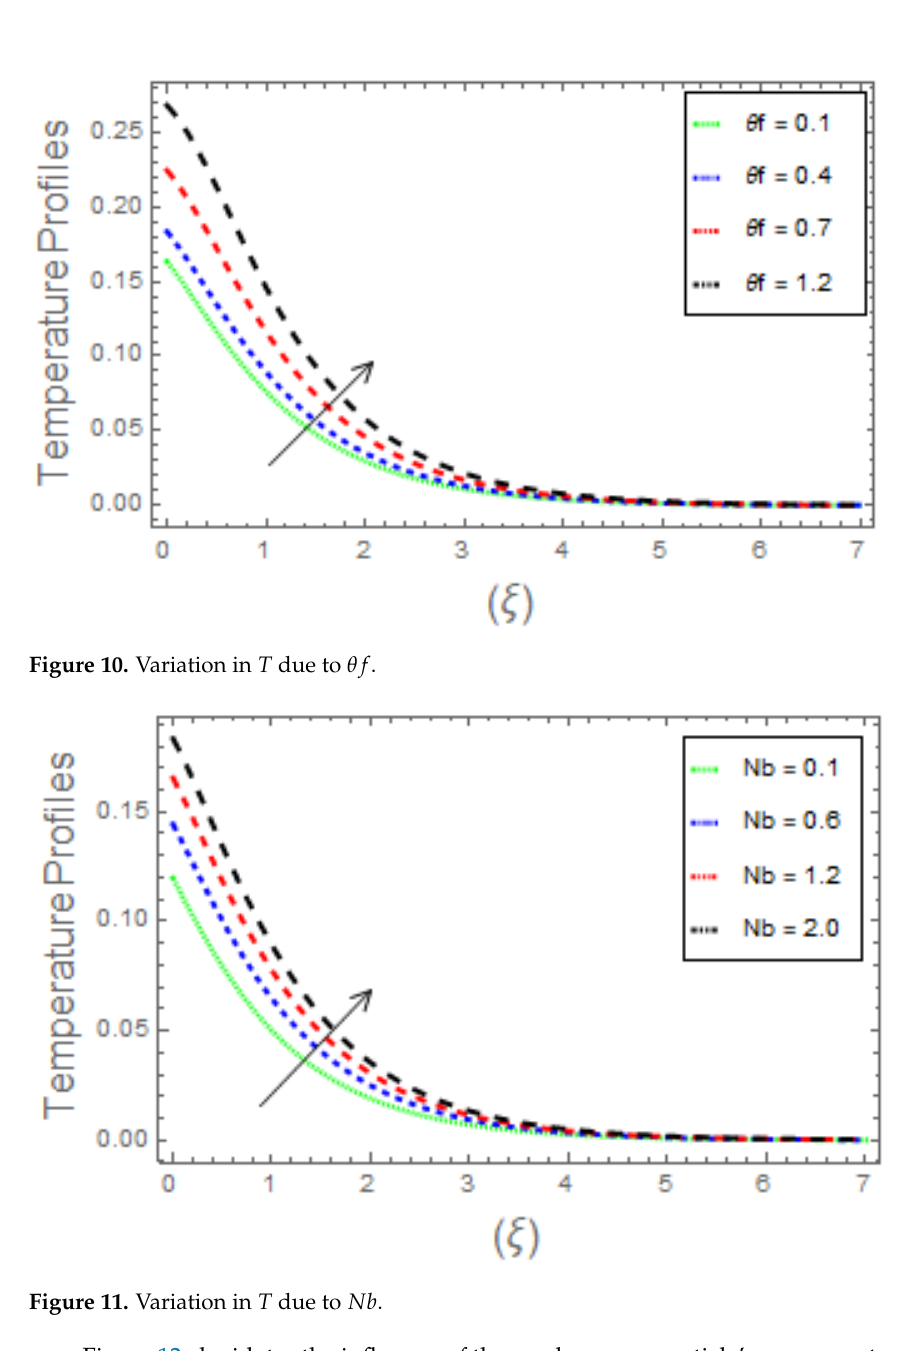
Figure 11. Variation in T due to Nb . Figure 12 elucidates the influence of the random nanoparticle’s movement repre- ( ) C ξ outlines. The nanoparticle Brownian motion at the molec- sented by Nb on the ular level performs a central role in determining the thermal performance of nanoparticle